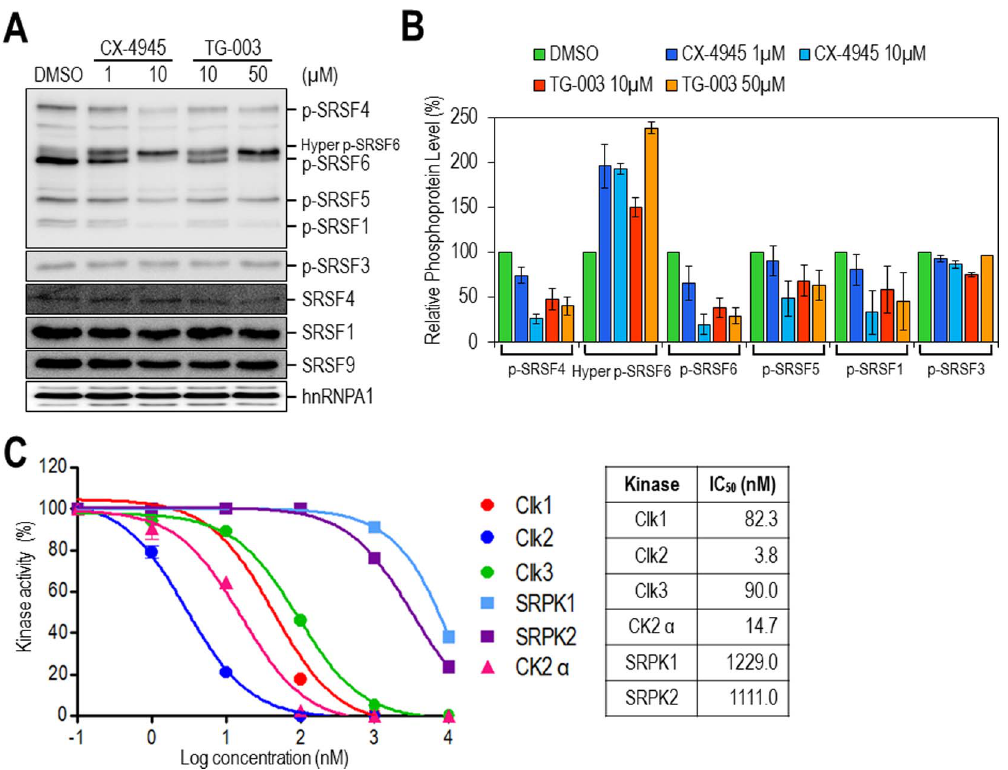
Figure 4. CX-4945 modulates SR protein phosphorylation via direct inhibition of Clks. (A) Total protein extracts from 293T cells treated with CX-4945 (1 and 10 m M) or TG-003 (10 and 50 m M) for 1 hour were separated by SDS-PAGE, and phosphorylated SR proteins were monitored by western blotting using the phosphoSR monoclonal antibody (1H4). SRSF1, SRSF4, SRSF9, and hnRNP A1 proteins were also monitored as controls. Western blotting was performed twice, and representative data are presented. (B) The phosphorylated SR proteins in (A) were quantified, and amounts of each protein relative to those of DMSO-treated samples are shown. The average and SD values were determined from two independent experiments. (C) The potent inhibition of Clks by CX-4945 was observed in in vitro kinase assays conducted by Life Technologies using recombinant human Clk1, Clk2, Clk3, SRPK1, SRPK2, and Ck2 a proteins. The average and SD values were determined from two independent assays. The IC 50 values were determined using PRISM software. Detailed experimental procedures are described in the Materials and Methods.